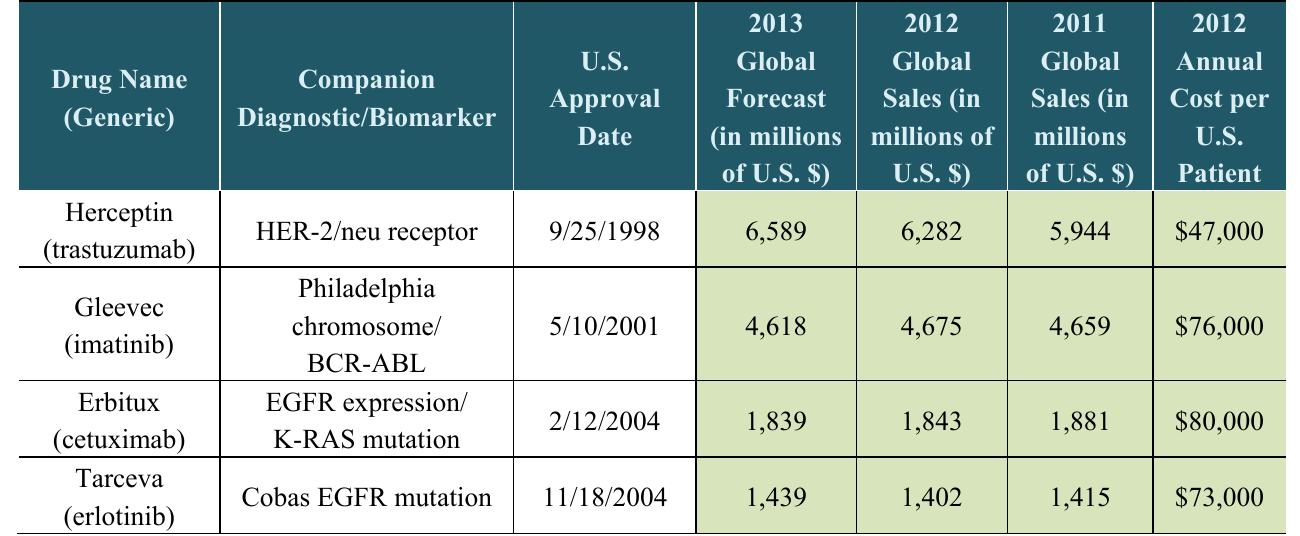
Table 2. Global sales of drugs and annual cost per patient